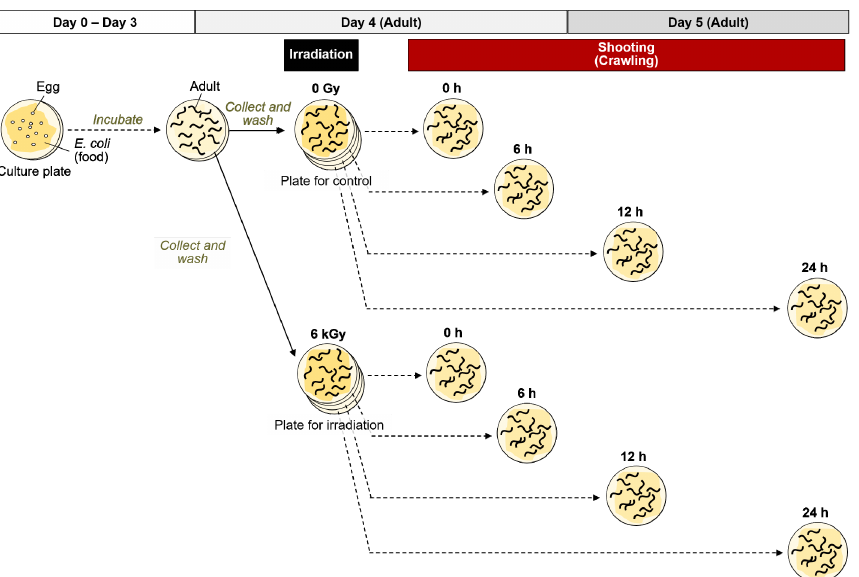
Figure 1. Procedure for time-course crawling assay of C. elegans after γ -ray irradiation. Well-fed adult worms were irradiated with a dose of 6 kGy of γ -rays on a NGM plate spread with a bacterial lawn. At 0, 6, 12, and 24 h after irradiation, the crawling of 5 worms, which were randomly selected from worms, were video-recorded, respectively. In the same way, non-irradiated control worms were video-recorded.